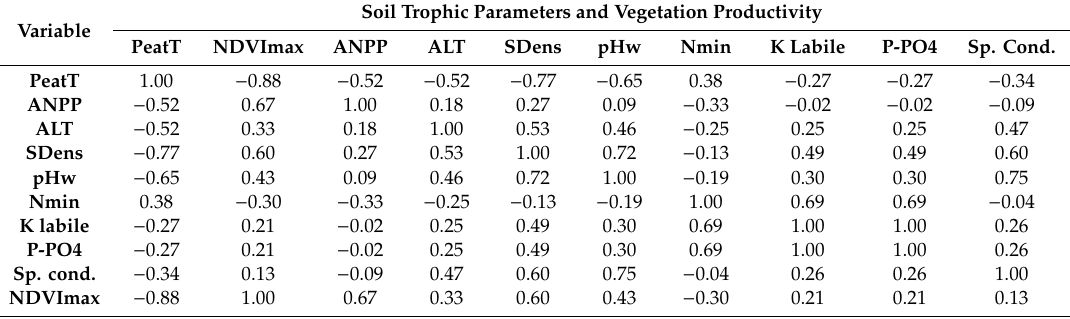
Table A4. Correlation matrix of the soil trophic parameters and vegetation productivity.